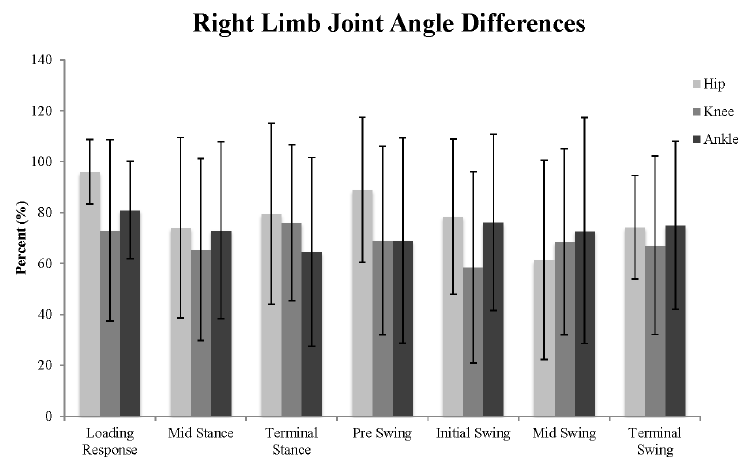
Figure 2. Mean ± one standard deviation of the number of significant sagittal plane joint angle differences (expressed as a percentage of the gait cycle sub-phase) between TD and ASD children averaged across the 10 matched pairs for the left and right hip, knee, and ankle joints. Table 1. Percentages of significant differences observed for hip, knee, and ankle position by Gait Phase, Limb and Matched Participant Pair.